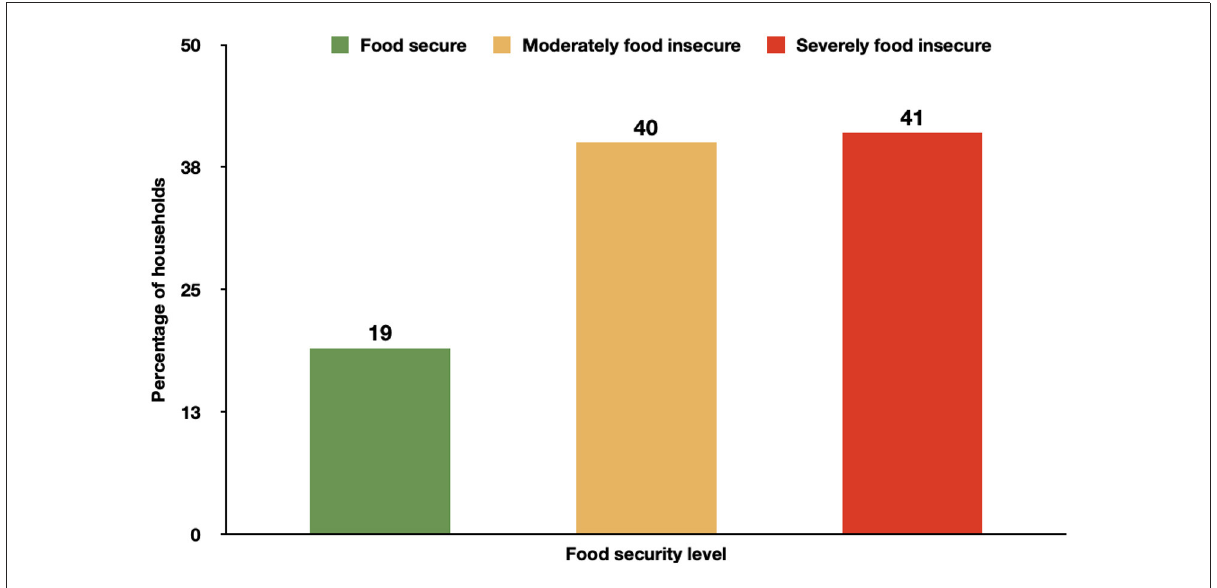
FIGURE2 Food security level of cattle farming households in Ghana.